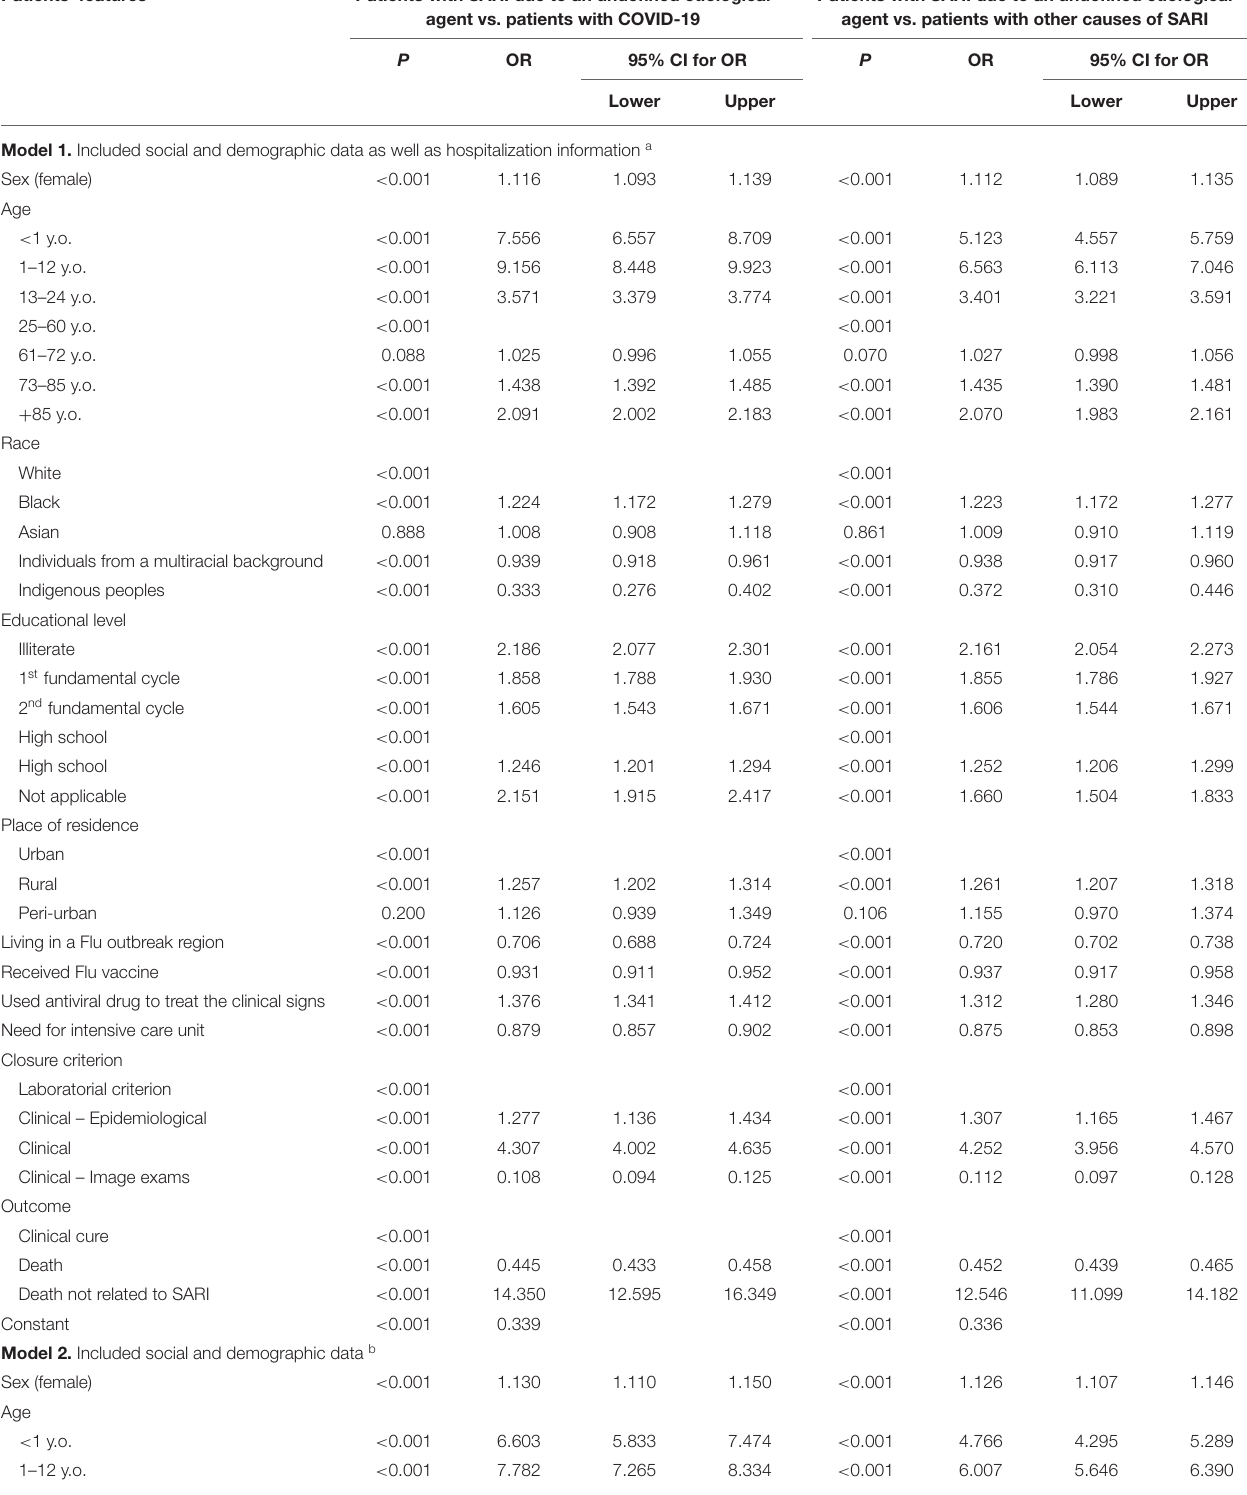
TABLE 4 | Multivariate analysis using Binary Logistic Regression for the association between the severe acute respiratory infection (SARI) categories and the features of the hospitalized patients due to SARI in Brazil during the Coronavirus Disease (COVID)-19 pandemic. Patients’